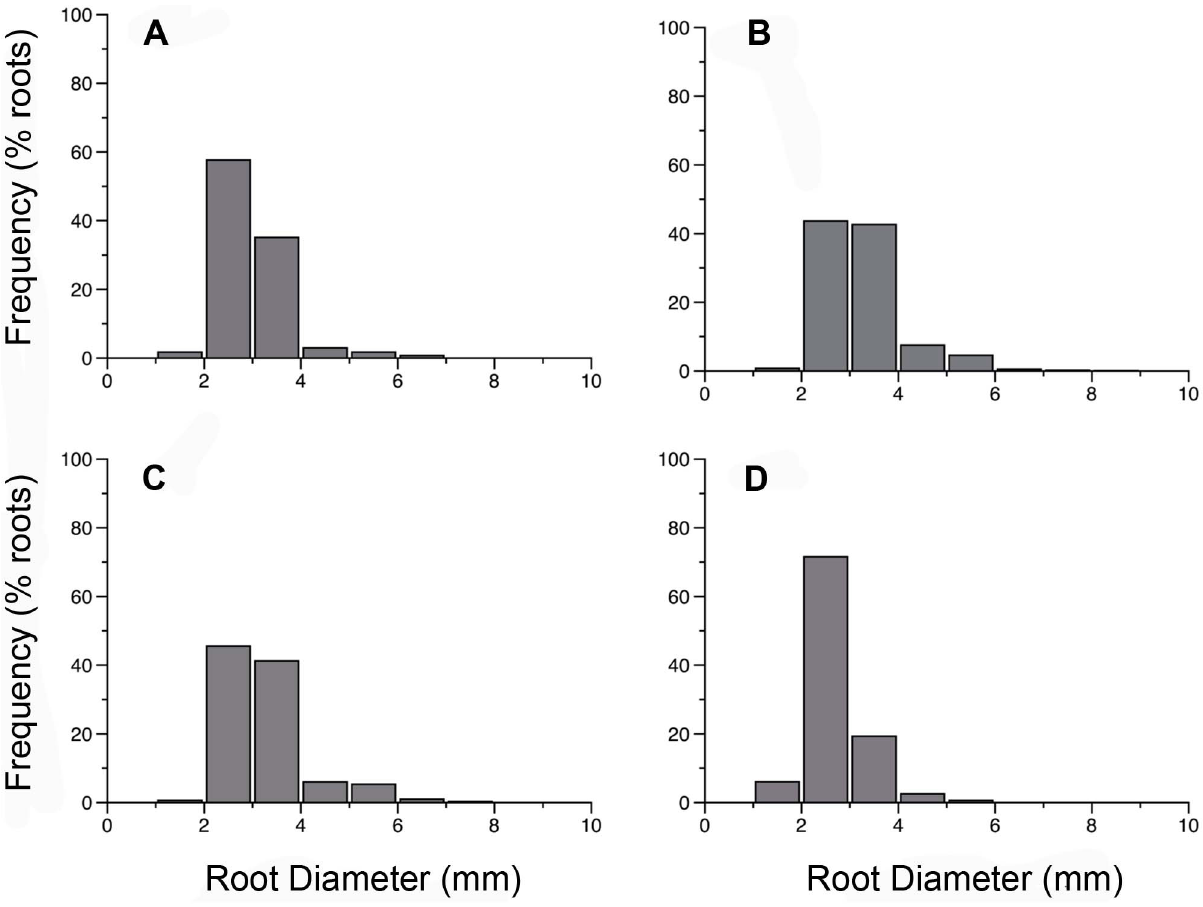
Figure 1. Frequency distribution of root diameters (mm) for first and second order roots of (A) L.japonica , (B) L.sempervirens , (C) F. alnus and (D) R.alnifolia .